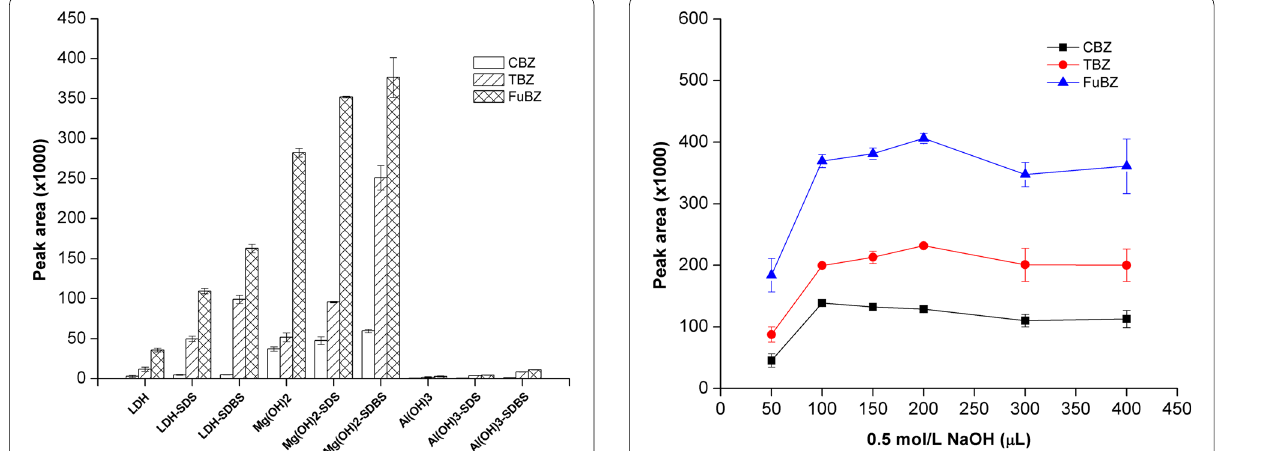
Fig. 1 Types of metal hydroxides co-precipitation methods for the preconcentration of target fungicides (100 μg/L each). LDH: 300 mmol/L MgCl 2 (90 μL), 300 mmol/L AlCl 3 (30 μL), 0.5 mol/L NaOH (100 μL); Mg(OH)